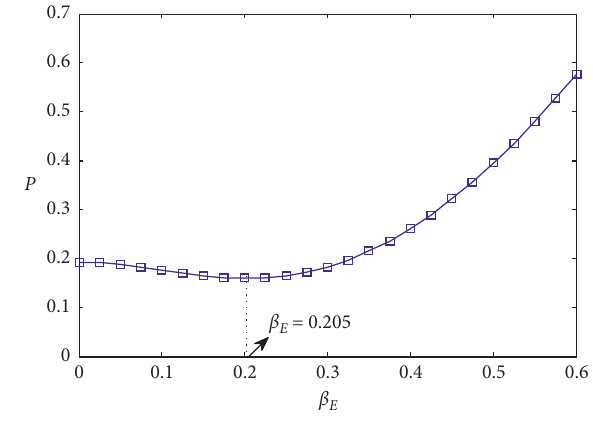
Figure 3: Changes of P as β